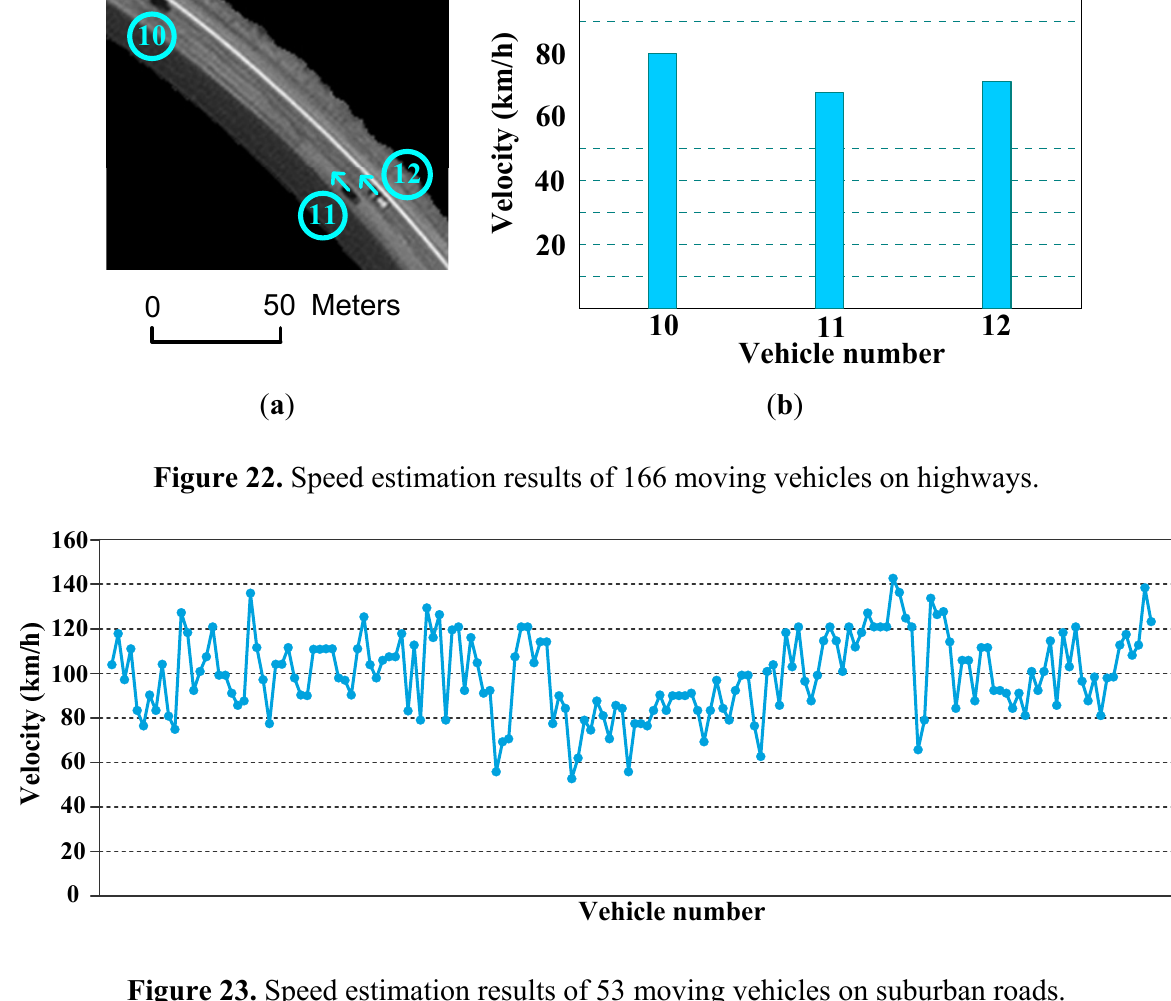
Figure 23. Speed estimation results of 53 moving vehicles on suburban